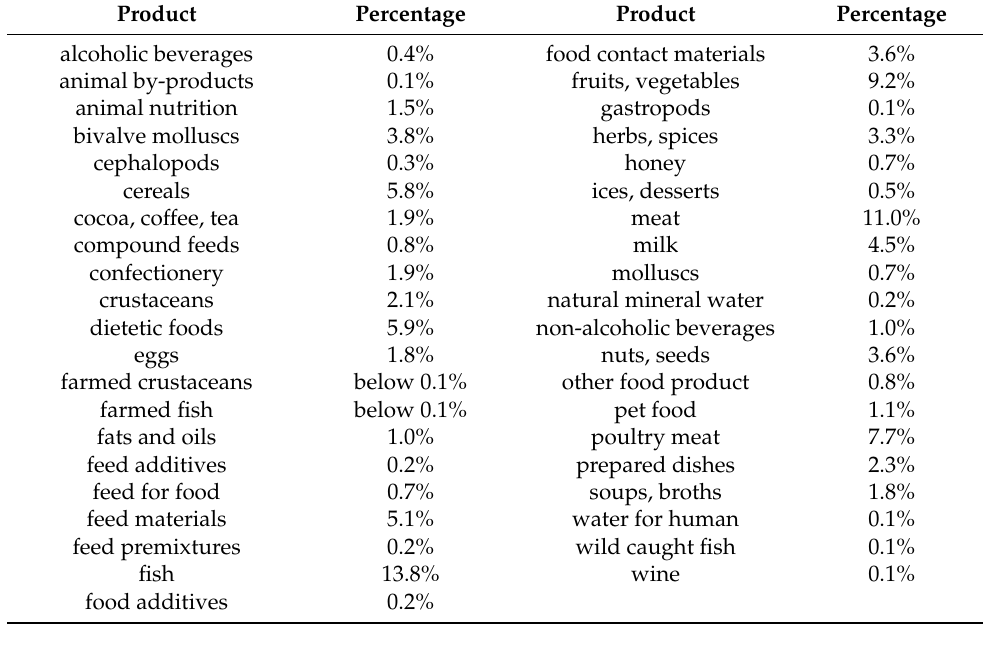
Table 5. Notifications in the Rapid Alert System for Food and Feed (RASFF) in 1999–2018 for particular products originated from EU countries.